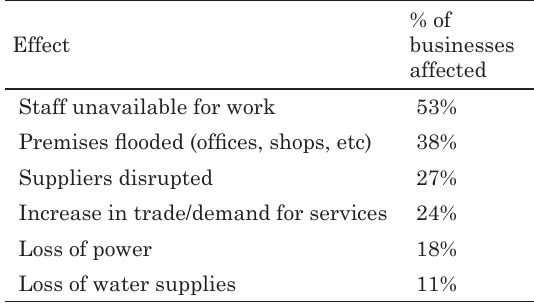
table 1. Effects of flooding on